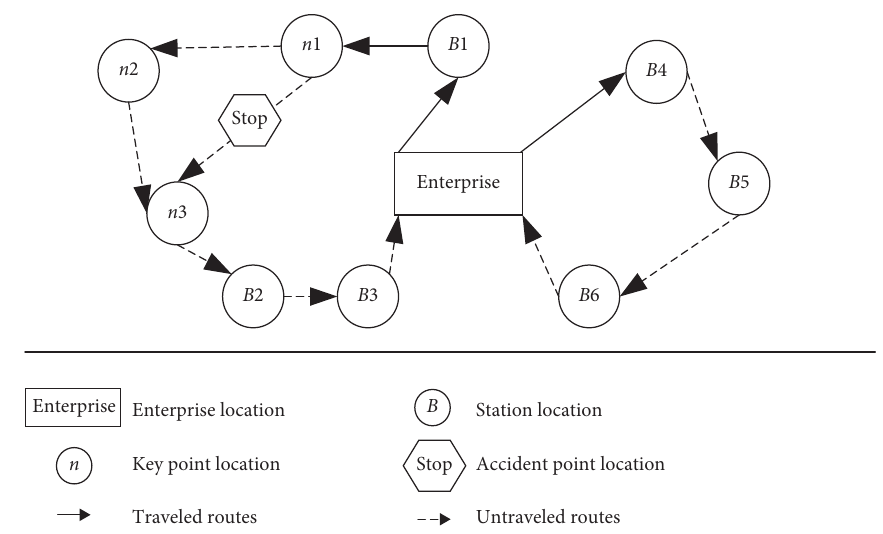
Figure 6: Dynamic adjustment of routes. Table 2: Survey of traffic jams in Qinhuangdao.